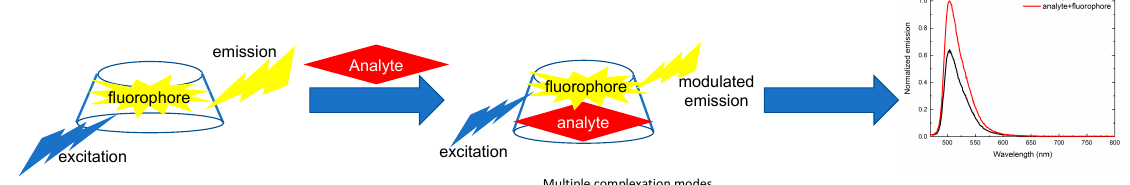
Figure 1. Scheme of cyclodextrin-promoted fluorescence modulation. This figure shows one possible complexation mode in which both the fluorophore and analyte are bound in the cyclodextrin. Other complexation modes are possible.